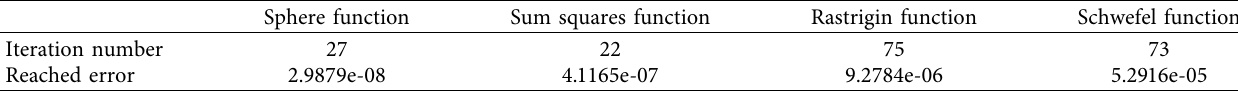
Table 1: Computing results of the four benchmark